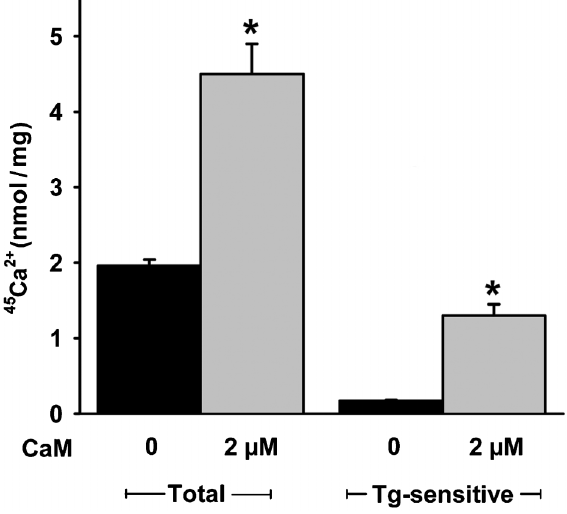
Figure 5. Phosphorylation of serine residues in sarco(endo)plas- mic reticulum Ca 2 + -ATPase (SERCA). Blots were obtained after incubation of phosphorylated membranes (5 m g) with anti-phos- phoserine residue antibody. The phosphorylation assays were performed in the absence ( lane 1 ) or presence ( lane 2 ) of 10 m M free Ca 2 + and 2 m M calmodulin (CaM). Control ( lane 3 ) without Ca 2 + , calmodulin and ATP shows no preexisting phosphorylation.